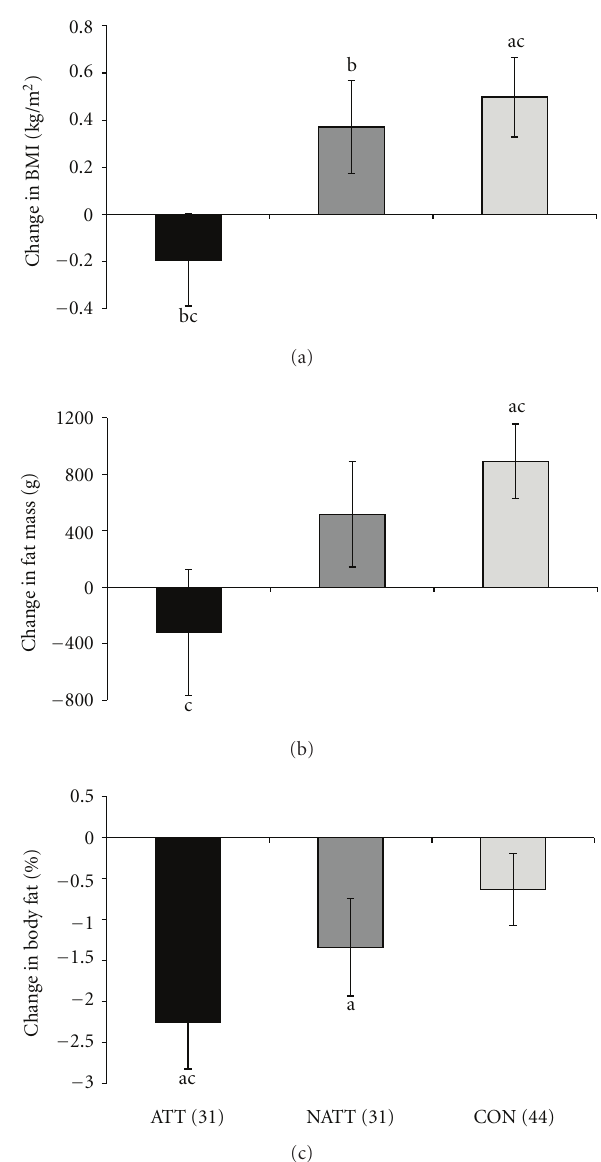
Figure 2: Baseline and follow-up measures of (a) BMI (kg/m 2 ), (b) fat mass (g), and (c) body fat (%) for the ATT group (black bars), NATT group (dark grey bars), and Control group (light grey bars). Values are means ± SE. (a) Significant di ff erence from baseline to followup; (b) change from baseline to followup is significantly di ff erent between ATT and NATT groups; (c) change from baseline to followup is significantly di ff erent between ATT and Control